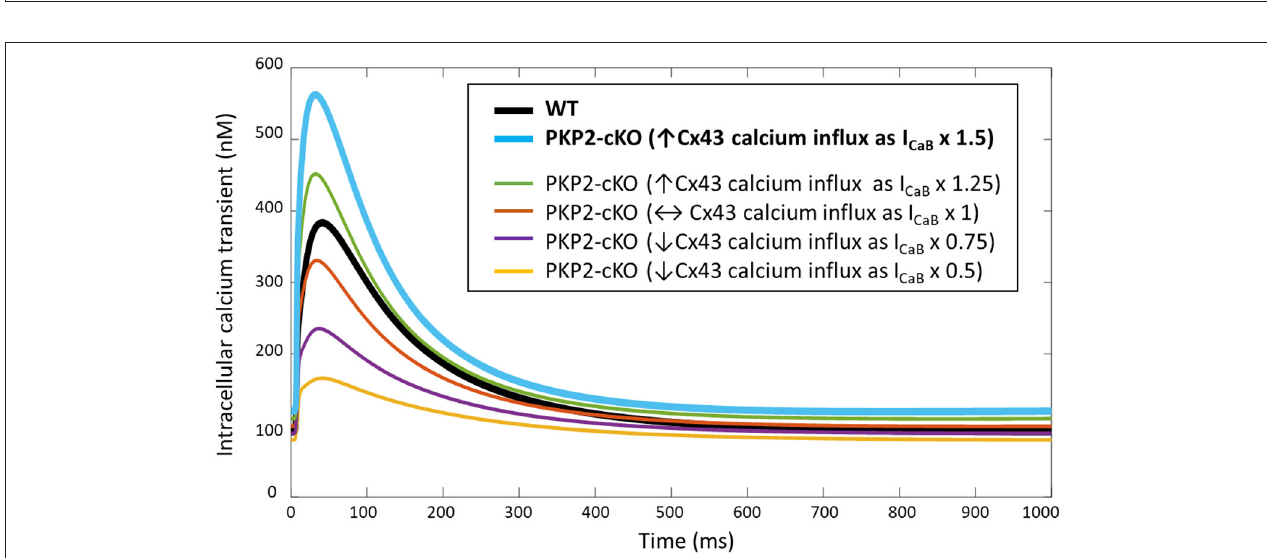
FIGURE 3 | Intracellular calcium transient in WT and PKP2-cKO models with varying scaling of I CaB (1.5 – baseline model, and 1, 0.5, 0.75, 1.25), to mimic different magnitudes of background calcium influx via Cx43 hemichannels.